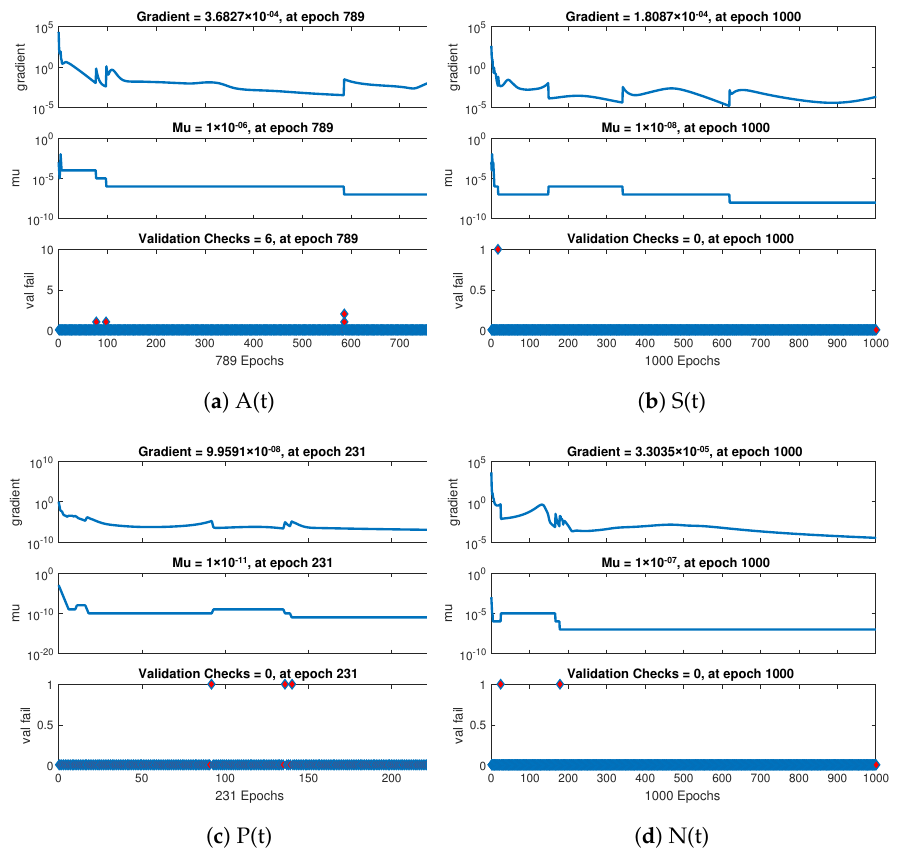
Figure 9. Performance based on validations failure, mu, and gradient of NNs-LMT for case